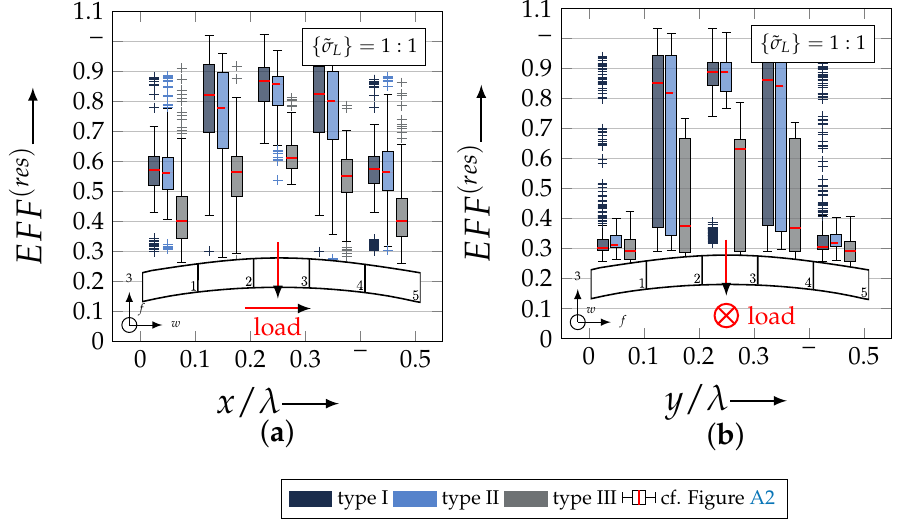
Figure 25. Illustration of resultant stress effort EFF ( res ) per defined normalised section according to Figure 13a at load ratio { ˜ σ L } = 1:1 for ( a ) weft and ( b ) fill